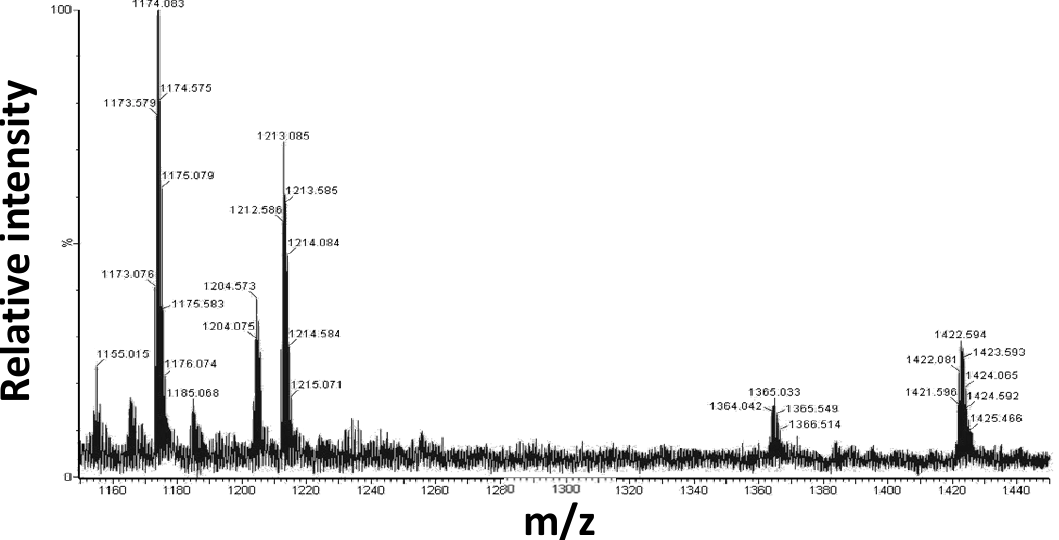
Figure 8. Electrospray ionization mass spectrometry (ESI) spectrum of A β 21–40 with 1 , after 24 h of incubation. All signals are generated from double charged